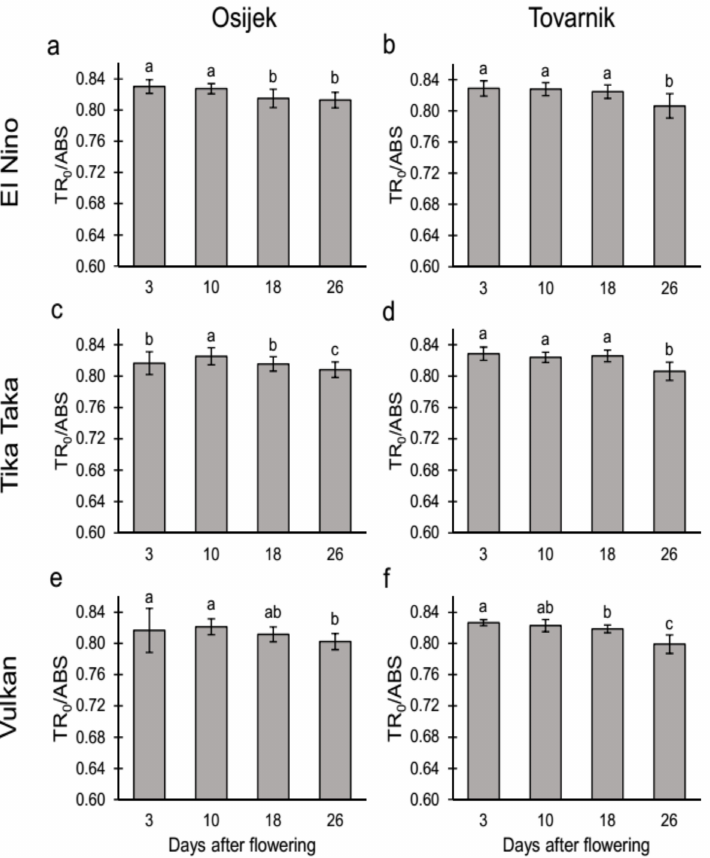
Figure 4. Maximum quantum yield of primary photochemistry (TRo/ABS) presented as mean value ± standard deviation of 20 flag leaves of variety El Nino ( a , b ), Tika Taka ( c , d ), and Vulkan ( e , f ) through four measurement points at two locations separately (Osijek and Tovarnik). Standard deviations are presented as vertical bars. Lower-case letters above columns are used to present results of statistical data analysis obtained by Fisher’s LSD test and point to statistically significant difference ( p < 0.05) between values of TRo/ABS measured at 3, 10, 18, and 26 days after flowering for each wheat variety separately and at each